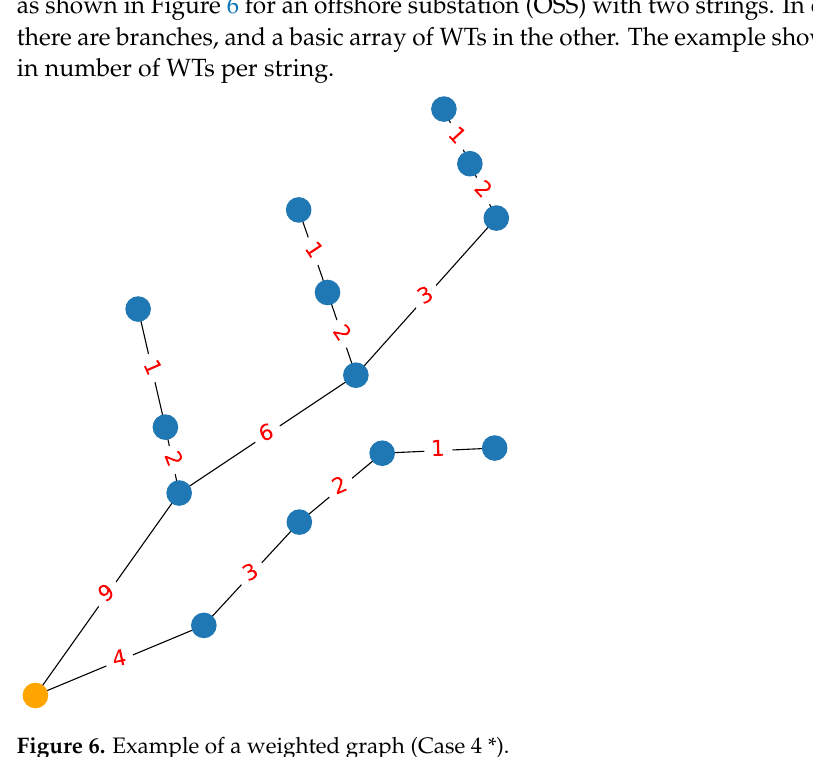
Figure 6. Example of a weighted graph (Case 4 *).